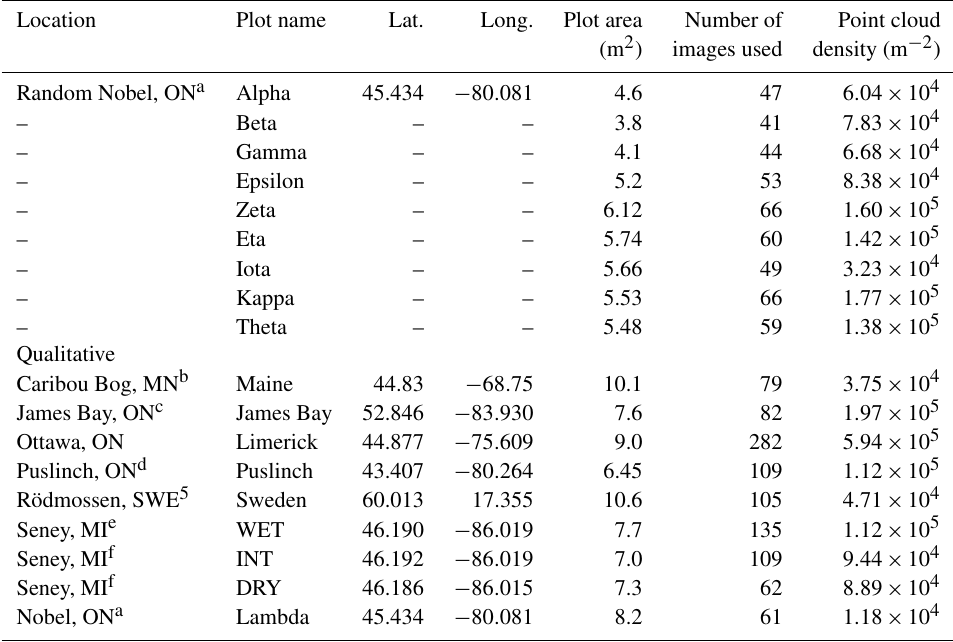
Table 1. Summary information, including latitude (lat.) and longitude (long.), on sample locations and SfM reconstructions of microtopo- graphic variation for randomly and qualitatively chosen plots. Sites listed below correspond only to those for plot-level